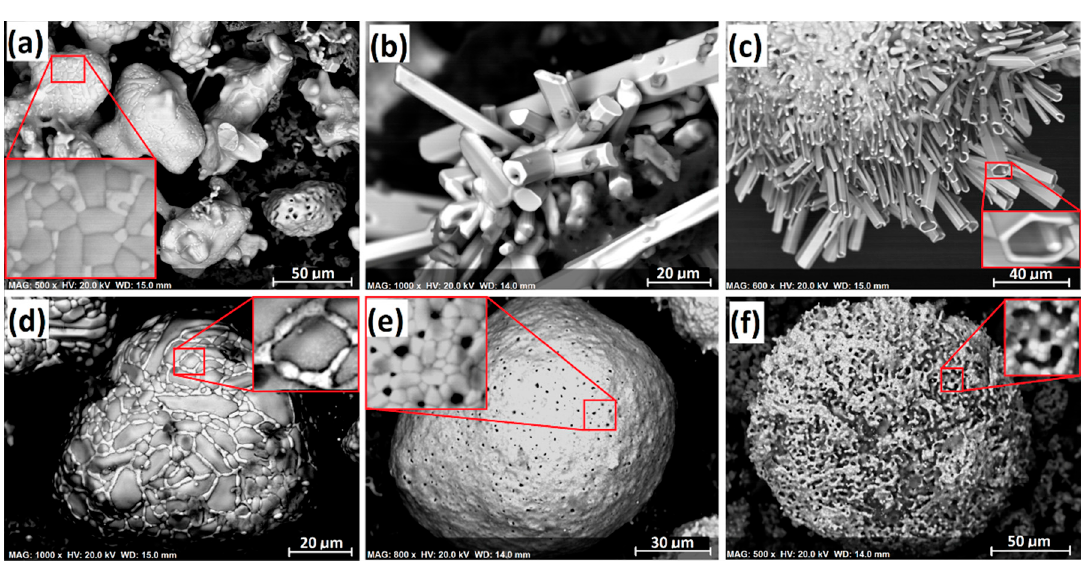
Figure 12. Various morphologies of the ferrochrome particles produced from reduction by charcoal ( a – c ) and petroleum coke ( d – f ). ( a – c ) and petroleum coke ( d – f